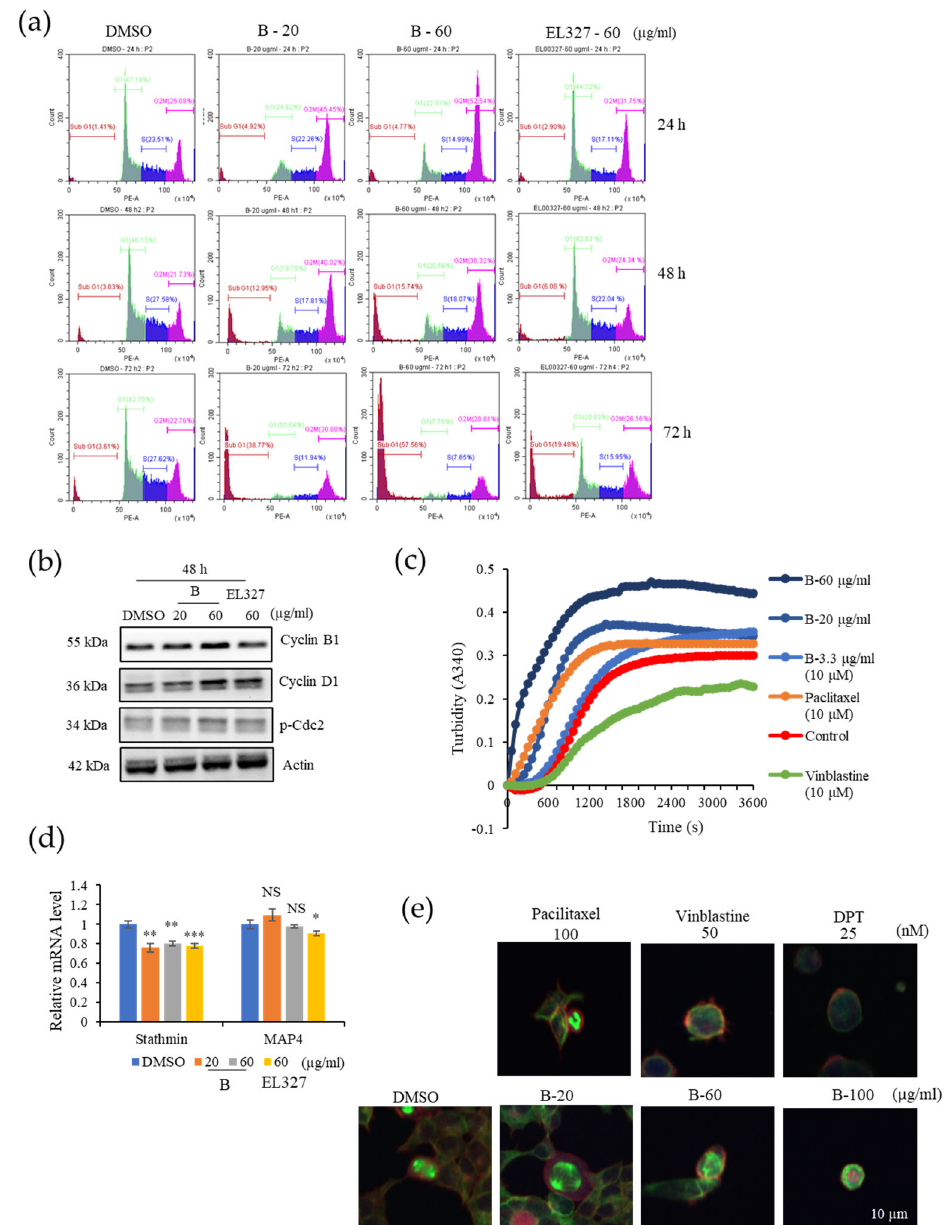
Figure 2. B induces G2/M phase arrest in Caco2 cells by inducing tubulin polymerization. ( a ) The cell ‐ cycle distribution of Caco2 cells treated with B (20, 60 μ g/mL) or EL000327 (60 μ g/mL) for 24 h, 48 h, and 72 h as assessed by flow cytometry. ( b ) Western blot analysis of cell cycle regulating proteins, Cyclin B1, D1, and p ‐ Cdc2 after treatment with B (20, 60 μ g/mL) or EL000327 (60 μ g/mL) for 24 h, 48 h, and 72 h. ( c ) Effect of B on tubulin polymerization in vitro, at concentrations of 20, 60, and 3.3 μ g/mL. DMSO, paclitaxel, microtubule stabilizer (10 μ M), and vinblastine microtubule destabilizer (10 μ M) were used as the controls. ( d ) Relative mRNA levels of stathmin and MAP4, which are associated with microtubule destabilization and stabilization, respectively, after treatment with B (20, 60 μ g/mL) or EL000327 (60 μ g/mL) for 48 h. ( e ) Immunofluorescence microscopy of the microtubule organization in the Caco2 cells after treatment with B (20, 60, 100 μ g/mL), paclitaxel (100 nM), vinblastine (50 nM) or DPT microtubule destabilizer (25 nM) for 24 h. Actin was stained with Alexa Fluor 568 phalloidin (red), microtubules were stained with α‐ tubulin antibodies (green), and DNA was stained with DAPI (blue). Results are representative of three independent experiments. Data represent the mean ± S.D. * p < 0.05, ** p < 0.01, *** p < 0.001, NS: no significant difference ( p > 0.05) compared with the DMSO ‐ treated control group.